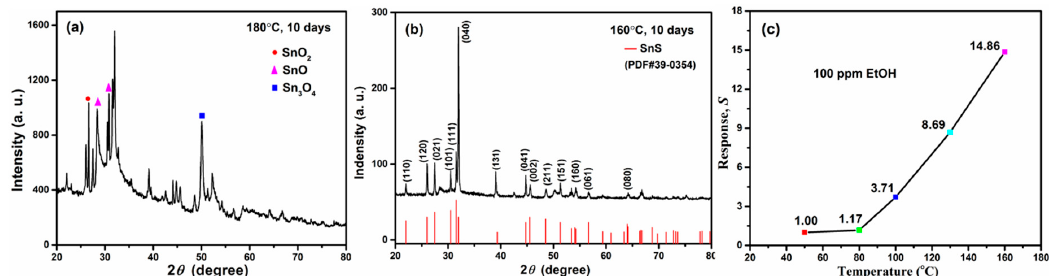
Figure 9. ( a ) XRD pattern of SnS samples which underwent heat treatment at 180 °C for 10 days in air. ( b ) XRD pattern of SnS samples which underwent heat treatment at 160 °C for 10 days in air. ( c ) The response S of sensors made of SnS nanosheets in the presence of 100 ppm of EtOH gas operating at different temperatures.